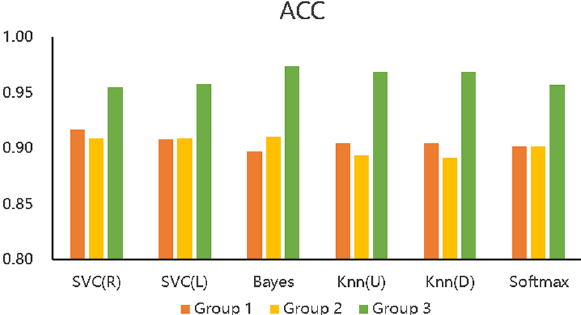
Figure 5. Accuracy of the three types of prediction models.